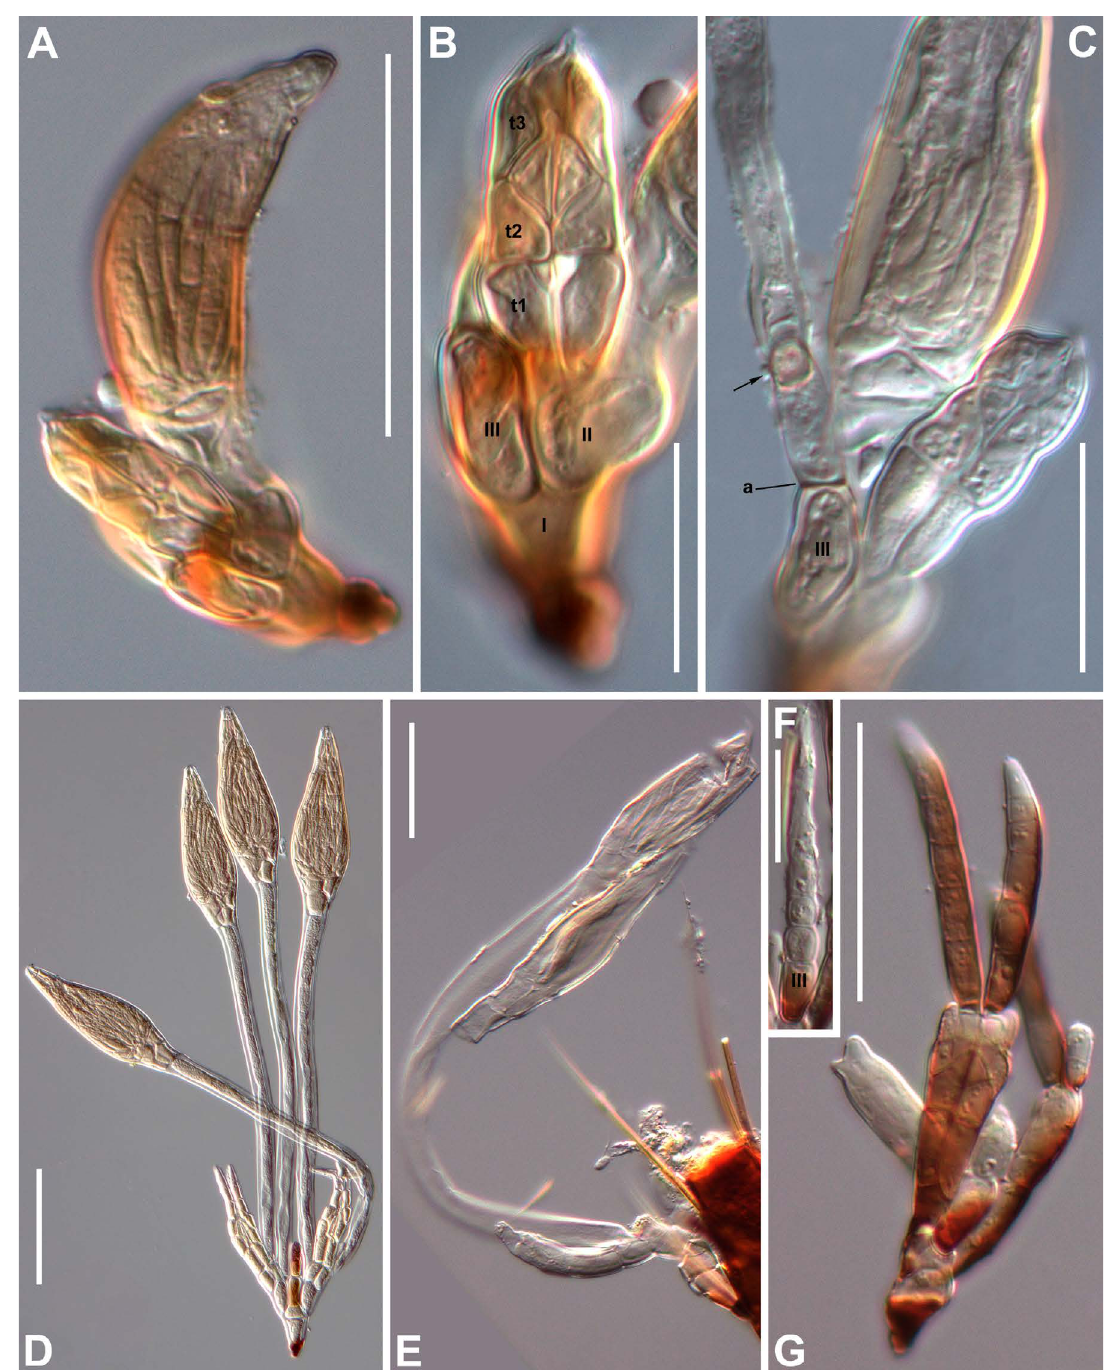
Fig. 89. Monoicomyces spp. A – C . M. matthiatis T.Majewski. A . Mature thallus. B . Lower receptacle (I, II, and III) and antheridium (tiers of cells labelled with t1–3) in detail. C . Central area of a thallus in detail showing cell III, the primary septum (a), and the darkened, oblique septum separating the basal inflated cell from the elongated apical cell of the primary appendage (arrow). – D – E . M. myllaenae Santam. D . Mature thallus from Spanish type slide kept in BCB. E . Broken and damaged thallus from Denmark. – F – G . M. nigrescens Thaxt. F . Primary appendage in detail showing cell III at the base. G . Immature thallus. Scale bars: A, D–E, G = 50 µm; B–C = 20 µm; F = 25 µm. Photographs from slides ZMUC C-F-123613 (A–C), BCB-SS2329c (D) (holotype), ZMUC C-F-124215 (E), ZMUC C-F-124217